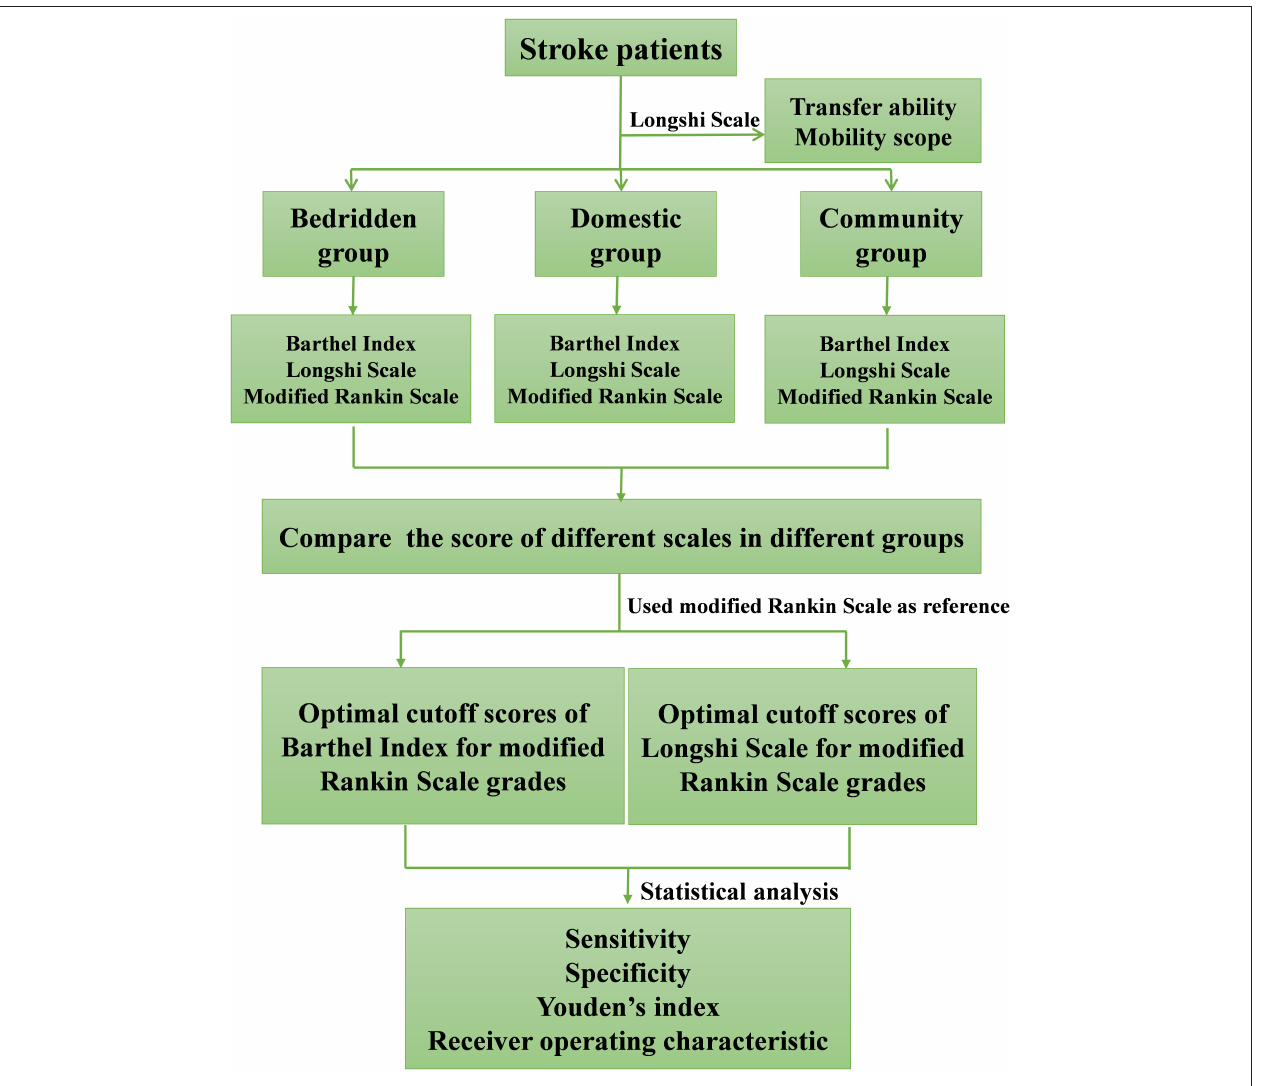
FIGURE 1 | Flow chart of study